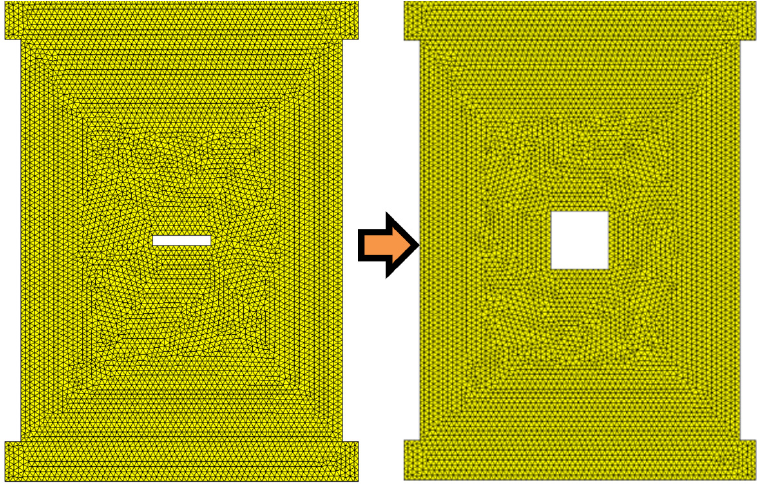
Figure 8. The height h of hole increases from 1 mm to 22 mm.